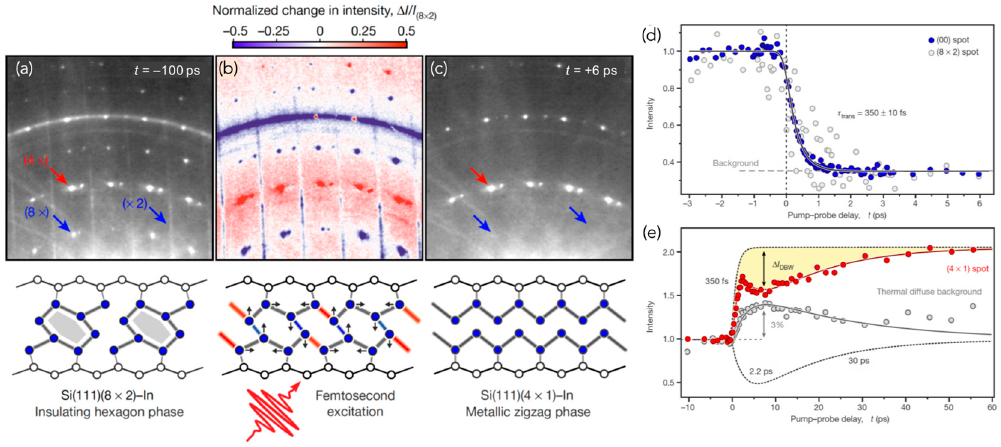
Figure 16. Structural transitions at surfaces, measurements in reflection geometry. ( a – c ) Fs-reflection high-energy electron diffraction (RHEED) patterns and surface structures. Diffraction patterns at T = 30 K before ( a ) and 6 ps after ( c ) laser excitation. Surface structures are sketched below, with In and Si atoms depicted as filled blue circles and open circles, respectively; In–In bonds are shaded grey. ( a ) In the insulating phase, the In atoms form distorted hexagons in an (8 × 2) reconstructed unit cell. ( c ) In the metallic phase, the In atoms rearrange to form zigzag chains with (4 × 1) structure. ( b ) Normalized difference between RHEED patterns ( c ) and ( a ). All of the (8 × 2) ground-state features disappear (blue), while most (4 × 1) spots gain intensity (red). ( d – e ) Time evolution of the diffraction intensities following photoexcitation with F = 6.7 mJ cm − 2 . ( d ) Transient intensity of the (00) spot and an (8 × 2) spot (rescaled) as a function of t . The solid line is an exponential fit to the data for the (00) spot, from which a time constant of τ trans = 350 fs, reflecting the structural change, is extracted. The (8 × 2) spot vanishes completely to the background level (dashed grey line). ( e ) Intensity of a fourth-order spot and the thermal diffuse background. The transient dip in the intensity of the fourth-order spot (yellow shaded area) at t = +6 ps indicates surface heating by ∆ T = 80 K (Debye–Waller effect), which coincides with the increase in background intensity. The fourth-order spot intensity is described (solid red curve) by the superposition of the two dashed lines, representing incoherent thermal motion (heating and subsequent cooling with time constants of 2.2 ps and 30 ps, respectively) and the structural transition with τ trans = 350 fs. Figure adapted from Reference [178] with permission from Springer Nature.